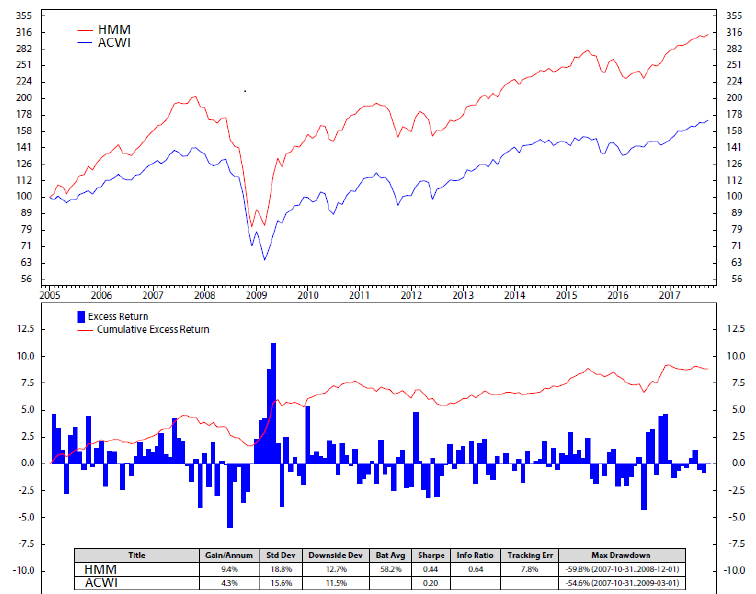
Figure 7. (log scale) Monthly global stock selection portfolio performances using HMM and the benchmark ACWI from January 2005 to September 2017. The stock prices were scaled to $100.00 at the beginning of the stock selection process (January 2005). The bottom table summarizes the performances of the portfolio, including annual gain (gain/annum), standard deviation, down- side deviation, batting average, Sharpe ratio, information ratio (info ratio), tracking error, and the maximum drawdown of the data.